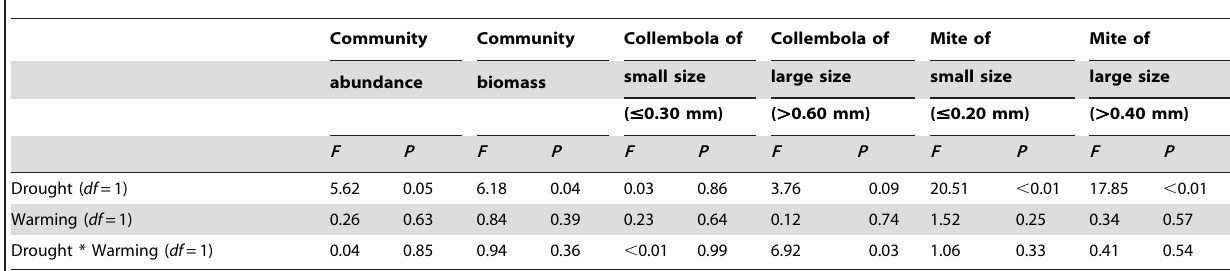
Table 4. Effects of drought and air warming on Collembola and mites.